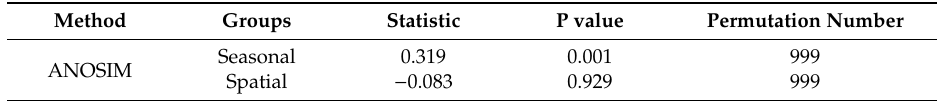
Figure 2. Non-metric multidimensional scaling diagram showing bacterial composition di ff erences obtained among the 24 sampling sites. Table 1. The ranks of the dissimilarities within and between groups for seasonal and spatial bacterial communities were estimated by ANOSIM (analysis of similarity